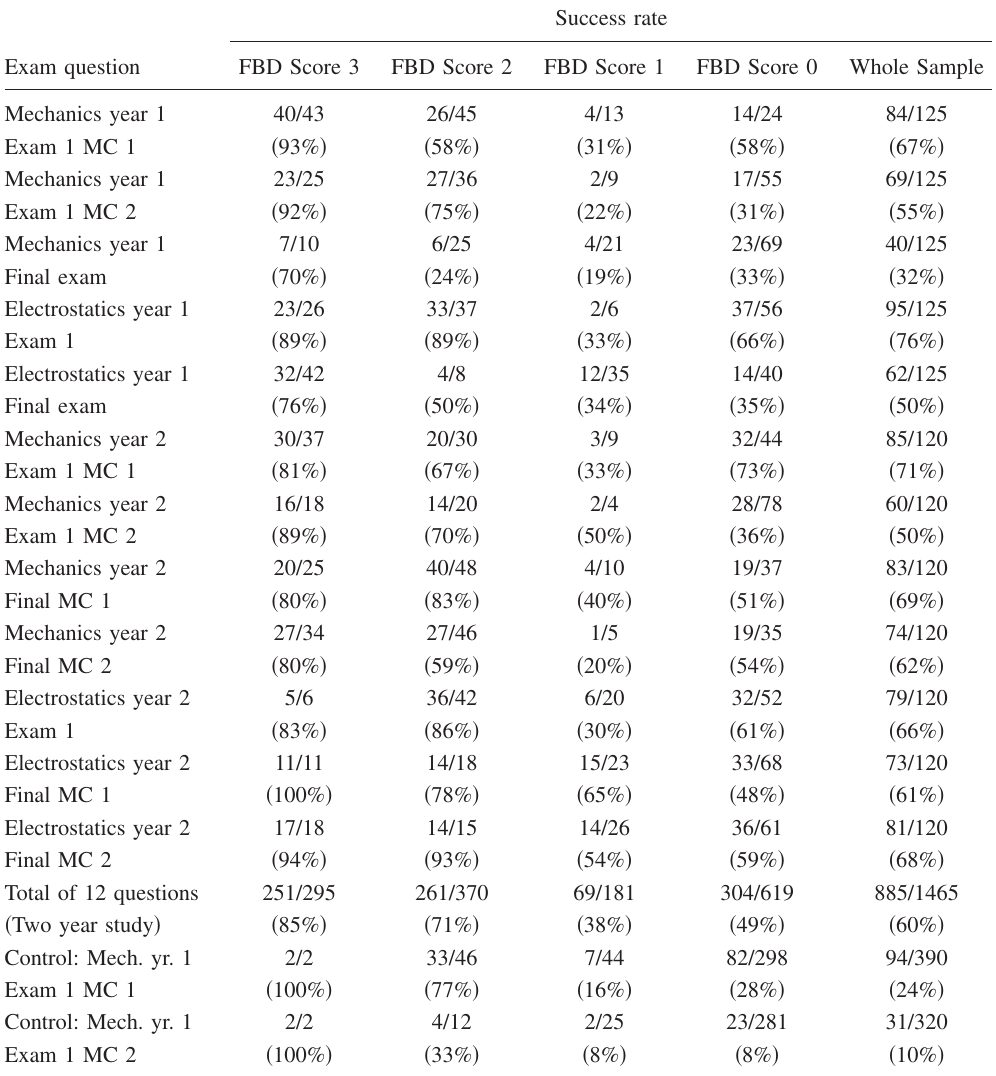
TABLE IV. Comparison of success rate of students for all 12 problems, total of all 12 and two control problems.